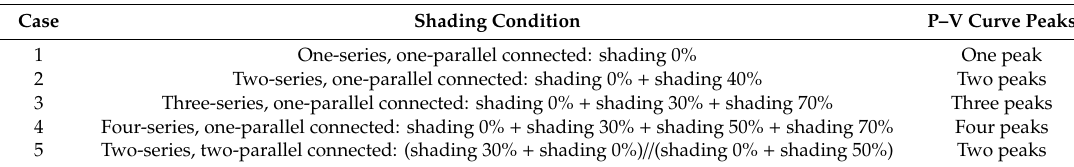
Table 4. Four shading conditions chosen.